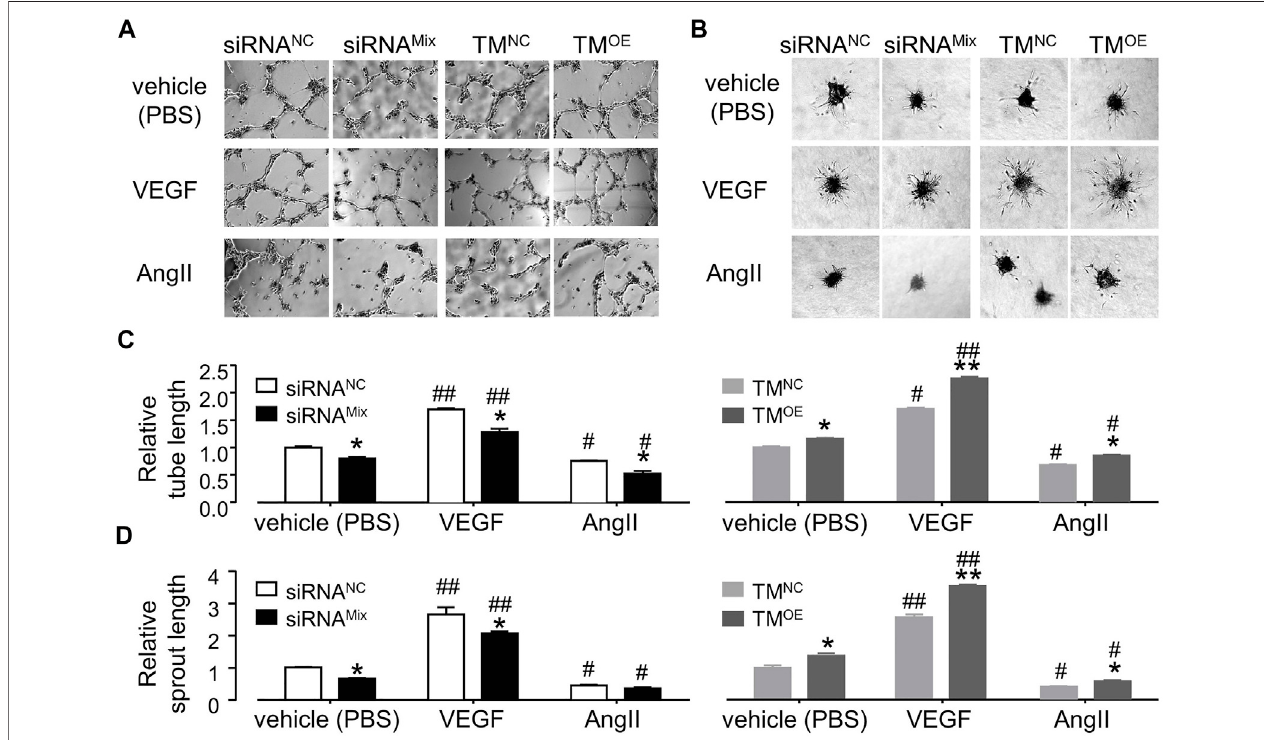
FIGURE 7 | Effect of TMEM16A on angiogenesis in HUVECs. (A,C) Tube formation assay results of HUVECs transfected with siRNA NC or siRNA Mix , or TM NC , or TM OE , and treated with vehicle (PBS), or VEGF (30 ng/mL), or AngII (1 μ M) separately (n = 3 – 9). (B,D) Endothelial cell spheroids sprouting assay results of HUVECs transfected with siRNA NC or siRNA Mix , or TM NC , or TM OE , and treated with vehicle (PBS), or VEGF (30 ng/mL), or AngII (1 μ M) separately ( n = 3 – 5). * p < 0.05 compared with siRNA NC or TM NC under the same treatment, # p < 0.05 and ## p < 0.01 compared with vehicle (PBS) in the same cell type, two-way ANOVA.